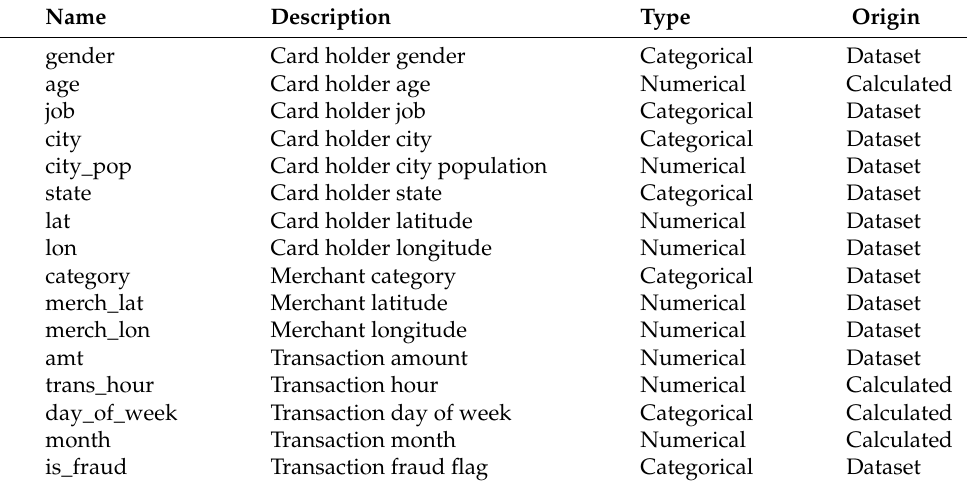
Figure 5. Frauds per month in Dataset 3. Table 2.